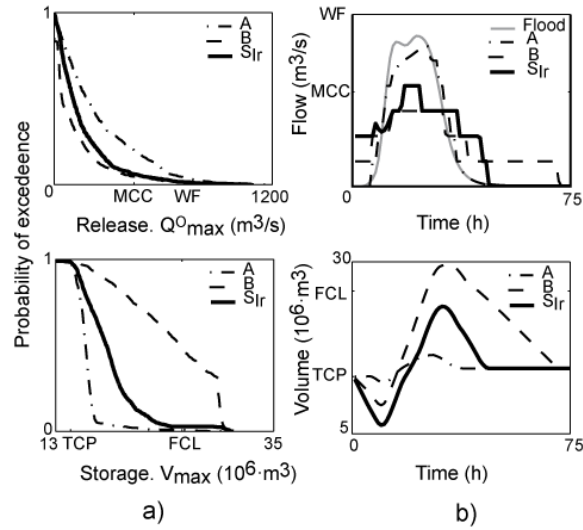
801 Fig. 9. Example of results for different parameter sets (A, B and Figure 9 . Example of results for different parameter sets (A, B and S S Ir ) and their bearing in the Puentes case: (a) probability distri- the Puentes case: a) probability distribution of the maximum volume released and maximum 803 bution of the maximum volume released and maximum stored; (b) stored; b) operation of the dam-reservoir for a given hydrograph. S operation of the dam-reservoir for a given hydrograph. S Ir shows between the two objectives of flood control 805 the aptest balance between the two objectives of flood